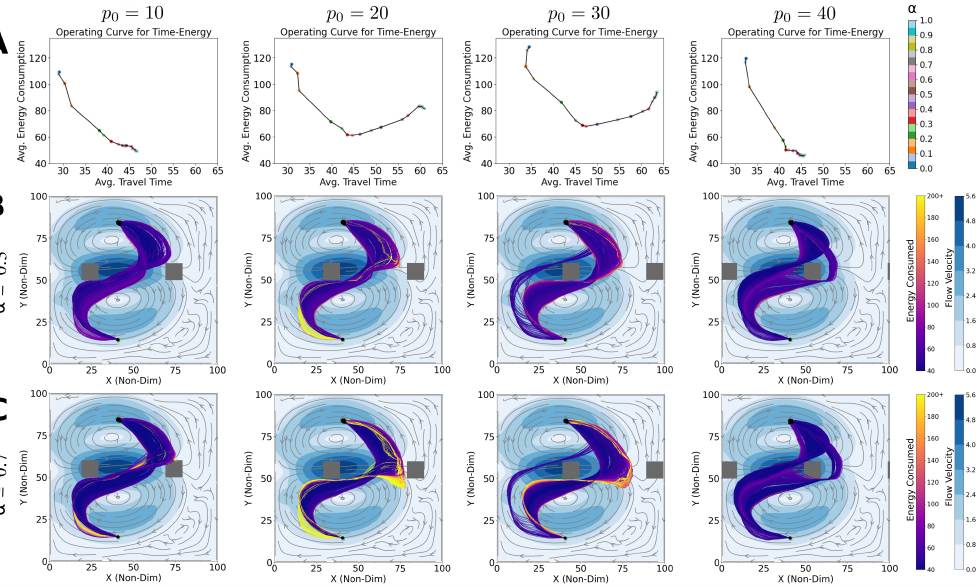
Figure 4. Operating curves and trajectories for optimal time and net energy mission with unknown p 0 : ( A ) Expected Time vs Energy operating curves for different initial positions p 0 of the obstacles. Each point is colored with its α value. ( B ) Distribution of final trajectories obtained by following the optimal policy for α = 0.3. Each plot along the row displays these trajectories for a given value of p 0 . ( C ) Same as ( B ) but for α = 0.7. All plots along a column correspond to the same p 0